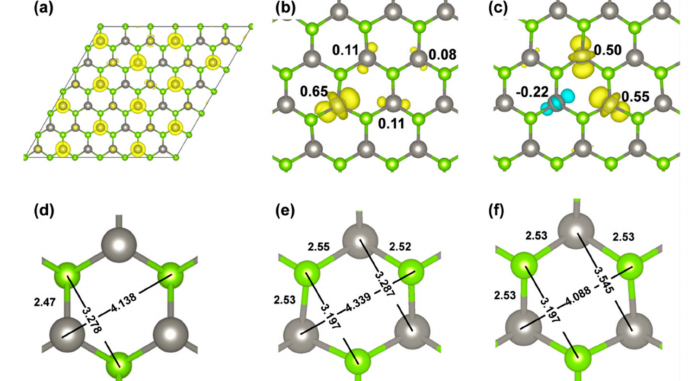
Figure 5. ( a , d ) are spin density and geometry of WSe 2 6 × 6 supercell with one more electron before geometry relaxation by HSE/CRY14; ( b , c ) are spin densities of two solutions for WSe 2 6 × 6 supercell with a self-trapped electron; ( e , f ) are the local geometries of solution ( b ) and ( c ), respectively. Distances are in Å. The isosurface level is 0.006 electron/bohr 3 for the spin density plots. Yellow and cyan are positive and negative spin densities, respectively. Mulliken electron spin density values on W atoms are given in ( b ) and ( c